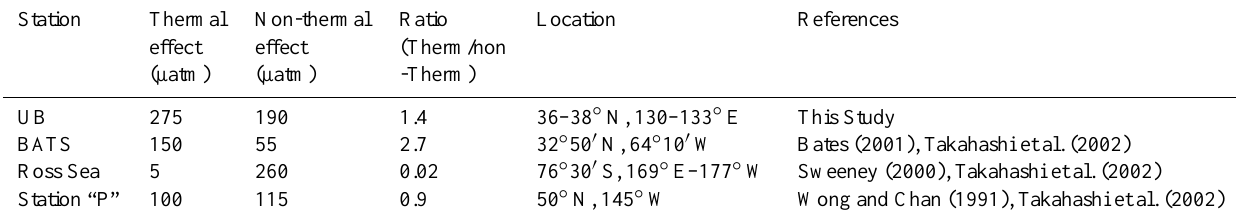
Table 2. Comparison of the contribution of thermal and non-thermal effects on the f CO 2 of surface seawater in various regions. Station Thermal Non-thermal Ratio Location